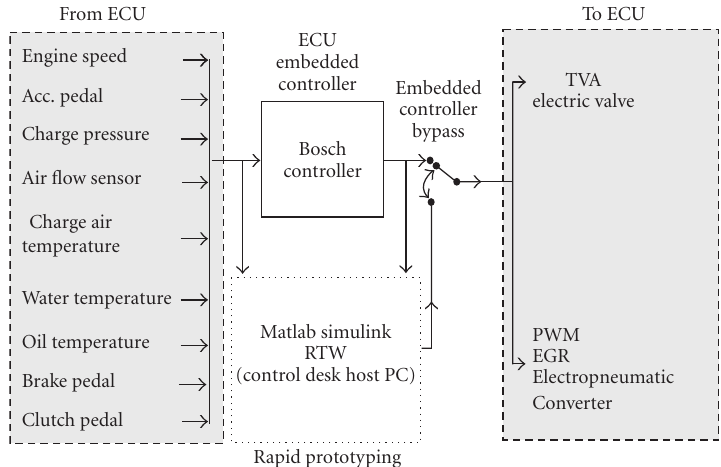
Figure 8: Integration of the real-time system with the test vehicle.